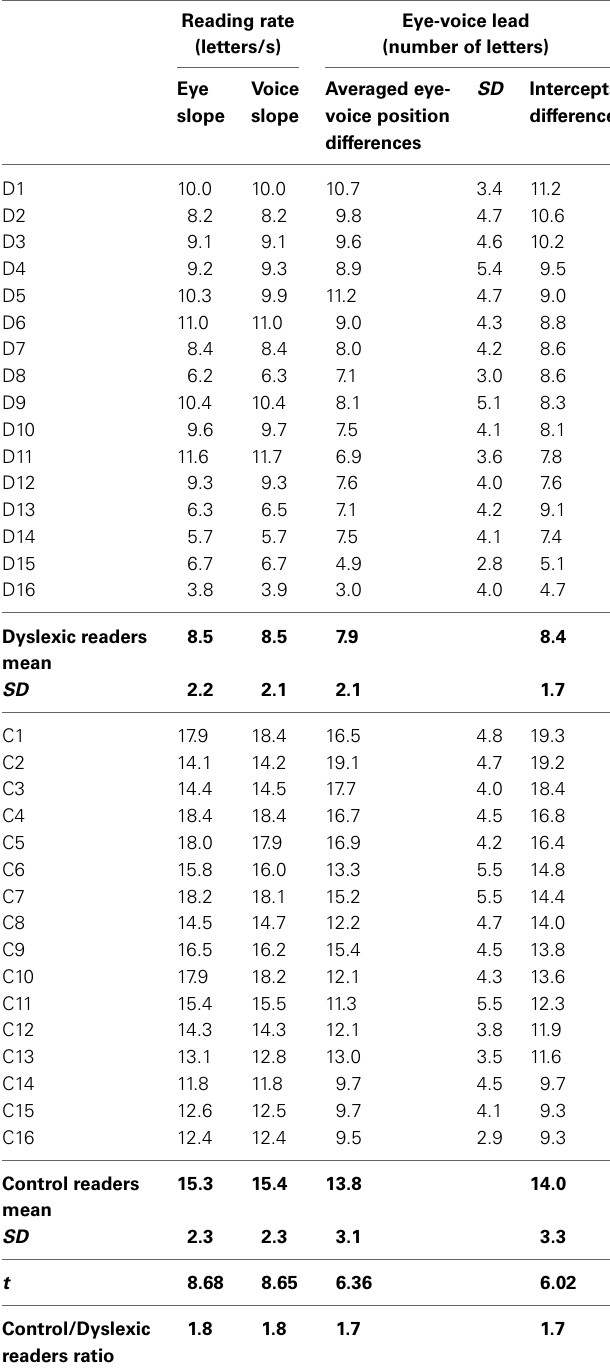
Table 5 | Eye-voice lead: mean individual data and group results. Reading rate